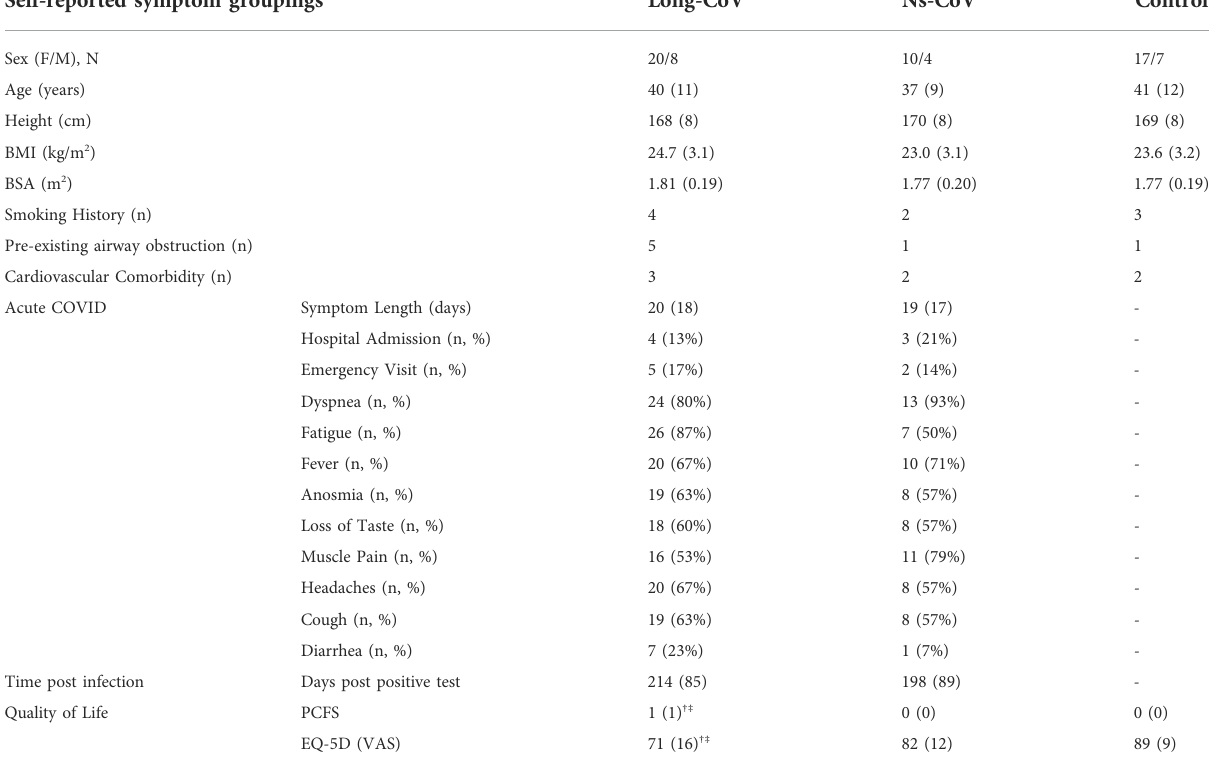
TABLE 1 Participant characteristics, symptoms during acute infection, and time since molecular con fi rmed positive COVID-19 test for Long-CoV, no-longer symptomatic (ns)-CoV and Controls. BMI, body mass index; BSA, body surface area; PCFS, Post-COVID Functional Scale; EQ-5D VAS, EuroQol 5-Dimension visual analog